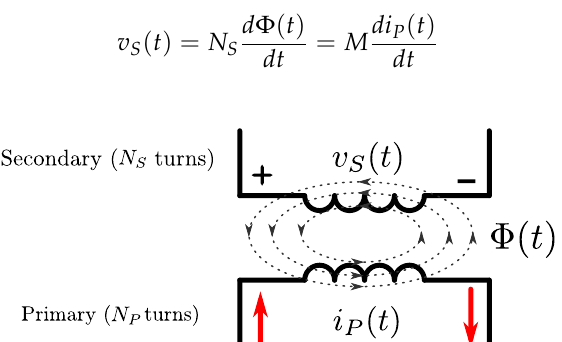
Figure 3. The interaction between two coupled inductors. A time-varying current i P ( t ) in the primary coil establishes a time-varying magnetic flux Φ ( t ) , a portion of which links the secondary winding and causes a time-varying voltage to be induced at its